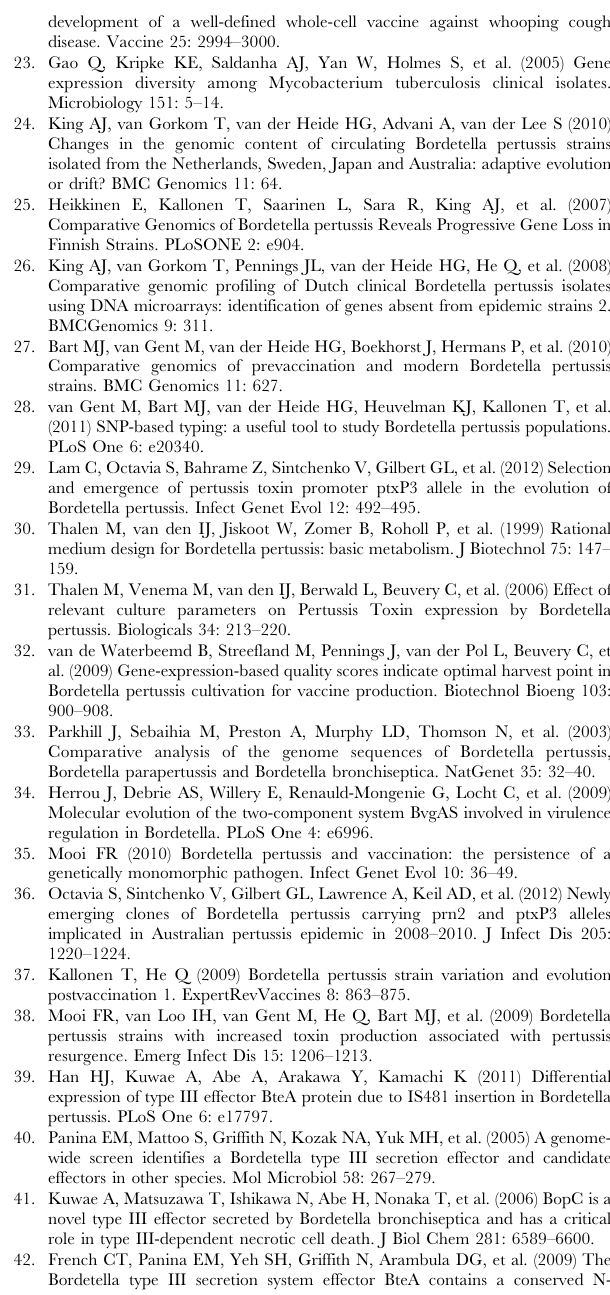
assays and 1 endogenous control are shown. The gene IDs for targeted genes are given in the first